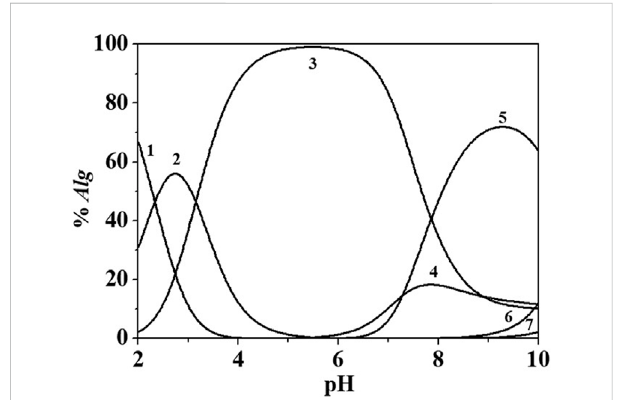
FIGURE 6 Distribution diagram of Eph-/Alg 2- species at I = 0.146 mol dm − 3 in NaCl (aq) , T = 298.15K, c Eph- = 3.00 mmol dm − 3 ; c Alg 2- = 1.50 mmol dm − 3 . Species: 1. H 2 (Alg) 0 (aq) ; 2. H( Alg ) - ; 3. ( Alg ) 2- ; 4.